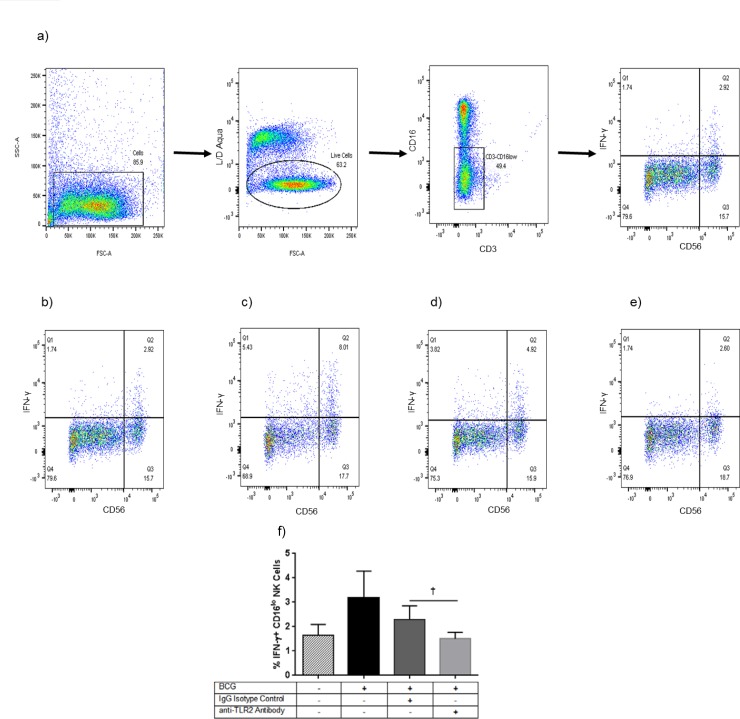
BCG stimulates CD16lo natural killer (NK) cells to produce interferon (IFN)-γ in a TLR2-dependent manner.Human neonatal NK cells were isolated from umbilical cord blood, stimulated with Bacille Calmette Guérin (BCG) overnight (in the presence of Brefeldin-A for the last 4 hours), stained with a vital dye (L/D Aqua), and intracellularly stained for CD3, CD16, CD56, and interferon (IFN)-γ for flow cytometry analysis. In Fig 4a-e, one representative experiment is shown. (a) gating strategy, (b) unstimulated control, (c) BCG stimulated, (d) BCG stimulated and pre-incubated with an isotype control antibody, (e) BCG stimulated and pre-incubated with a Toll-like receptor (TLR)2 blocking antibody. (f) Summary data for n = 5 independent experiments. Bars are mean values and error bars are S.D. † p = 0.06, BCG+TLR2 blocking IgG vs. BCG+isotype control IgG.